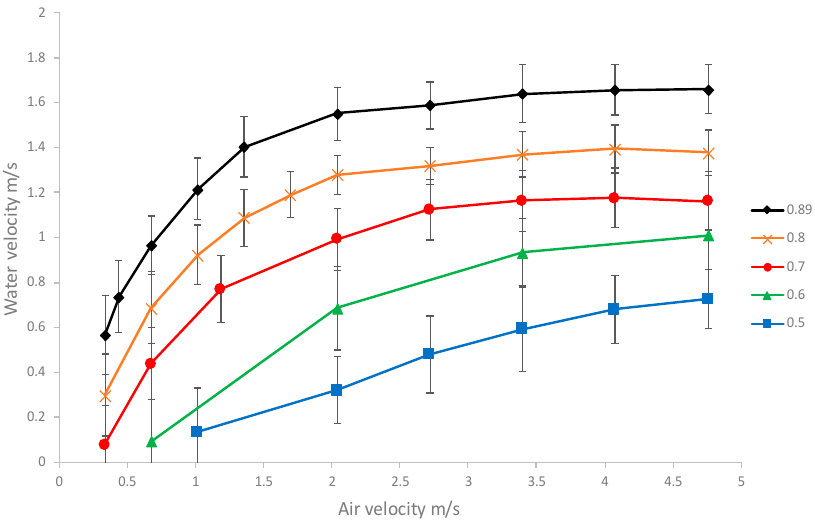
Figure 2. Experimental two-phase flow characteristics with different submergence ratio.